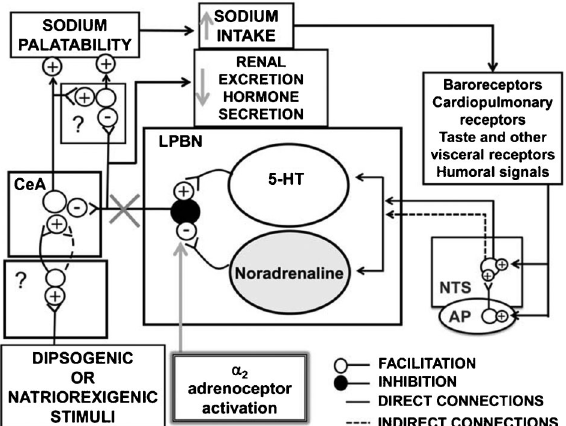
Figure 2. Schematic diagram showing how a 2 -adrenoceptors in the lateral parabrachial nucleus (LPBN) affect the control of sodium intake, sodium palatability, renal excretion, and hormonal secretion. 5-HT: serotonin; NTS: nucleus of solitary tract; AP: area postrema; CeA: central nucleus of the